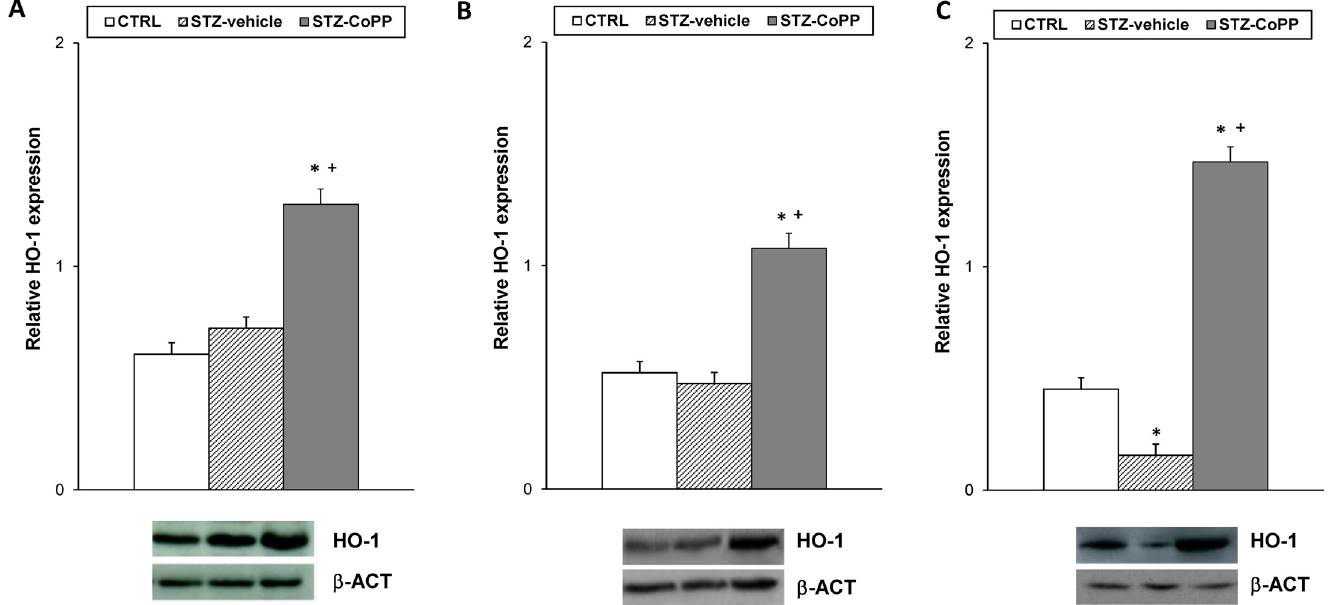
Fig 4. Effect of CoPP treatment on HO-1 protein expression in the spinal cord, dorsal root ganglia and sciatic nerve from STZ-injected mice. The protein expression of HO-1 in the spinal cord (A), dorsal root ganglia (B) and sciatic nerve (C) from STZ-injected mice treated with vehicle or CoPP is represented. The expression of HO-1 in the spinal cord, dorsal root ganglia and sciatic nerve from CTRL mice treated with vehicle has been also represented as controls. For each tissue, * indicates significant differences when compared to CTRL mice (p < 0.05, one-way ANOVA followed by Student Newman Keuls test) and + when compared to STZ vehicle treated mice (p < 0.05, one-way ANOVA followed by Student Newman Keuls test). Representative examples of western blots for HO-1 (32 kDa) in which β -actin (42 kDa) was used as a loading control, are also shown. Data are expressed as the relative expression ± SEM; n = 4 samples per